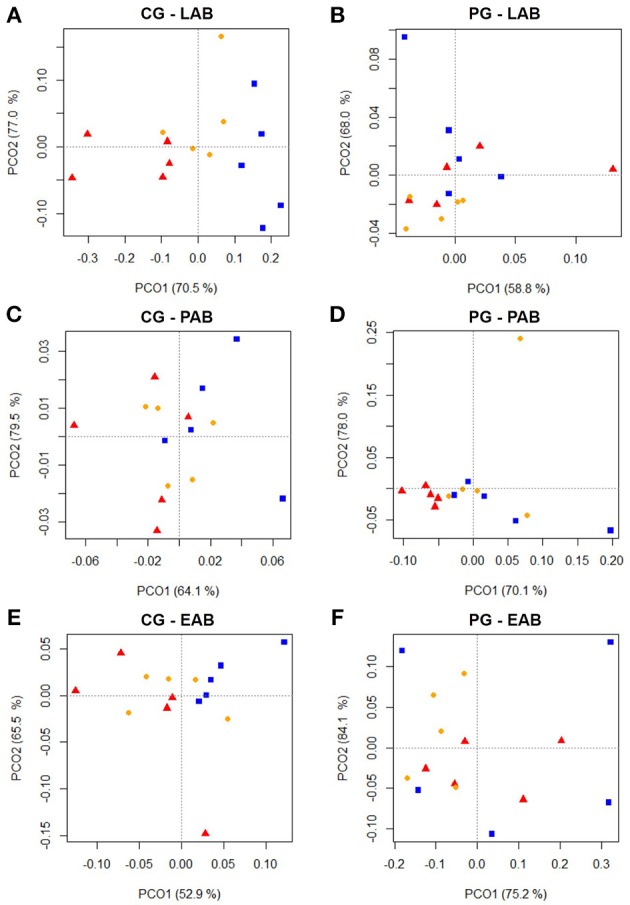
Two dimensional PCO-plots from SSCP-gels of rumen liquid (LAB), particle (PAB), and epithelium (EAB) associated bacteria illustrating changes over the course of the trial (wk 1 = red triangle, wk 5 = orange dot, wk 10 = blue square) in the confinement group (CG) and pasture group (PG; n = 5; explained variance indicated in % on x- and y-axis). The CG stayed on a TMR based ration during the entire trial while the PG was slowly introduced to a pasture-based ration: wk 1: TMR, wk 2: TMR and 3 h pasture/d, wk 3 and 4: TMR and 12 h pasture/d, wk 5–10: pasture and 1.75 kg DM concentrate/d. Significance: (A)
P = 0.141, (B)
P = 0.001, (C)
P = 0.080, (D)
P = 0.328, (E)
P = 0.013, (F)
P = 0.115.